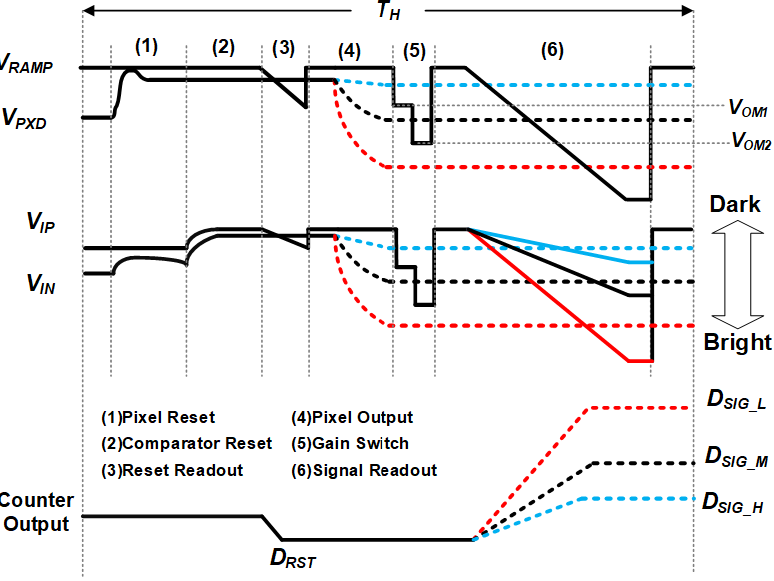
Figure 8. Timing diagram of the proposed gain-adaptive